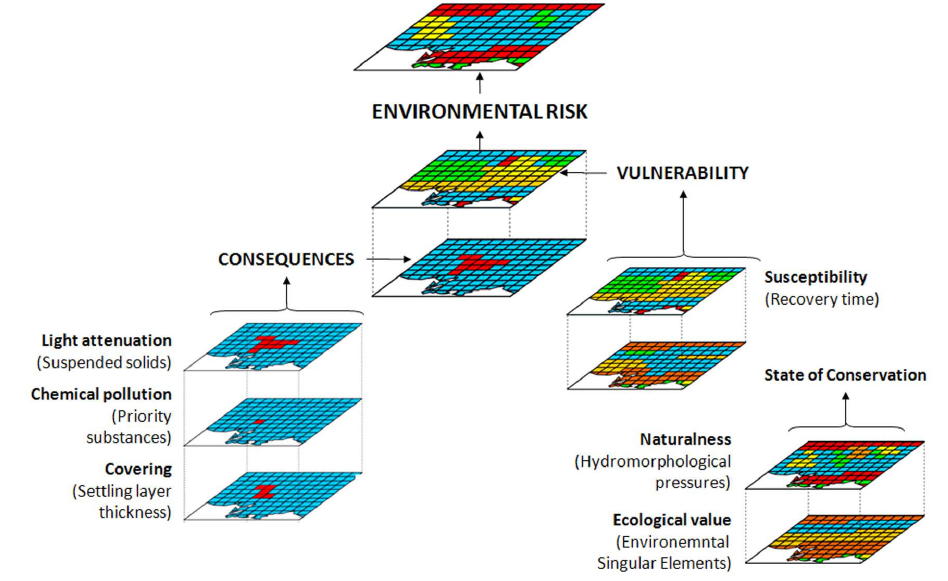
Fig. 1. Pathway for the integration process of indicators to estimate environmental